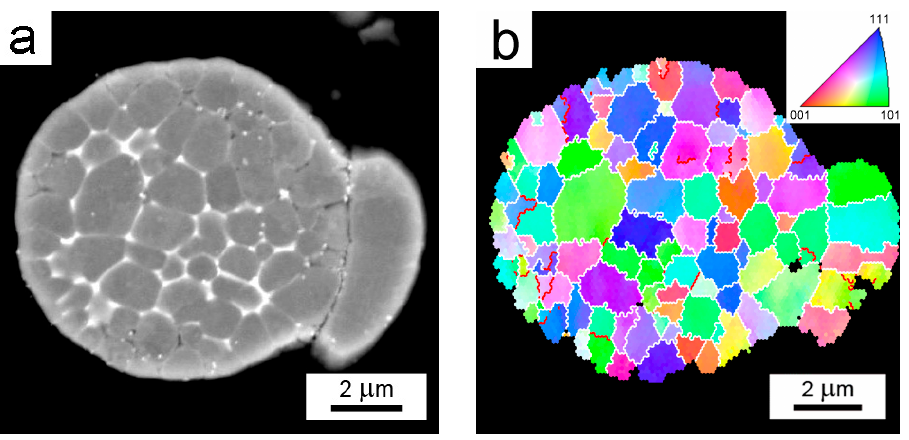
Figure 3. The solidification microstructure of the Al7075Zr_A powder particle ( a ) BSE contrast; ( b ) the corresponding electron backscattered diffraction (EBSD) micrograph and distribution of grain boundaries. Boundaries with misorientation angles above 15° in white, boundaries between 5° and 15° in red.